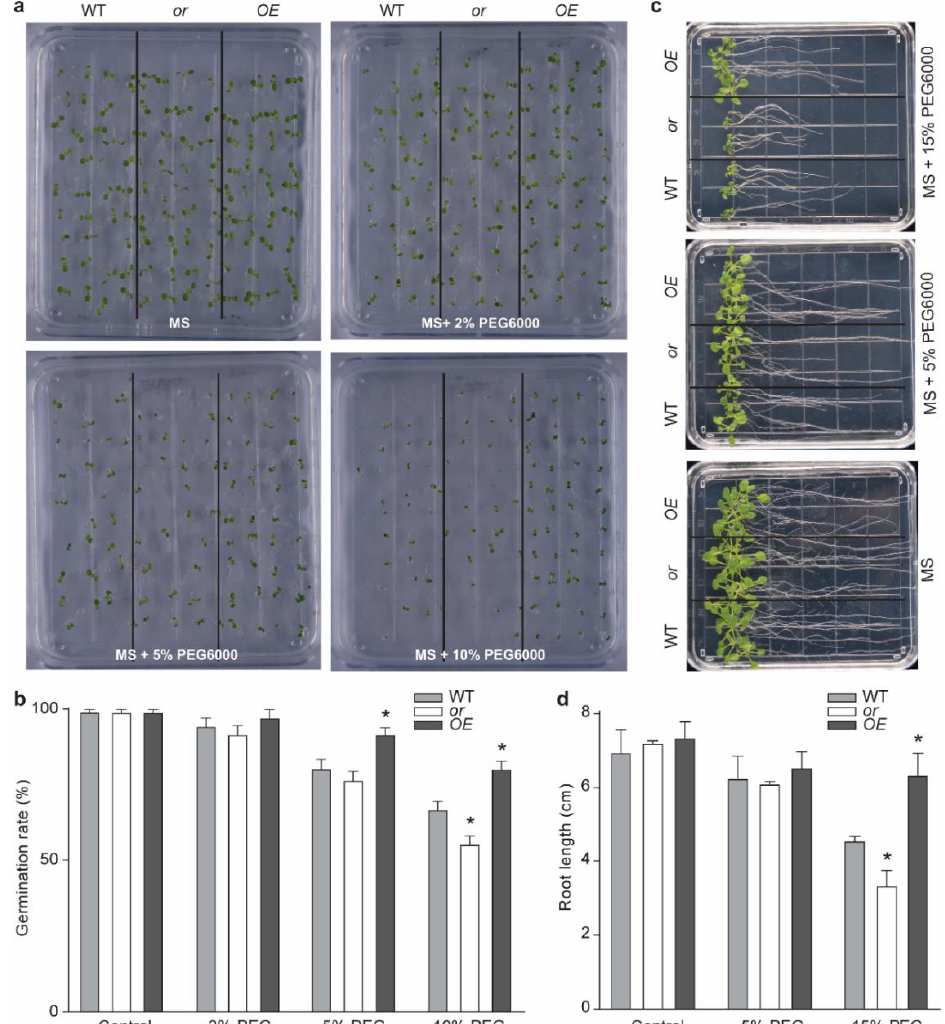
Figure 2. Response of different OR transgenic lines to PEG6000 treatment. ( a ) Germination of the wild-type (WT) and OR -overexpressing ( OE ) and -silencing ( or ) seeds on Murashige-Skoog (MS) plates, supplemented with indicated concentrations of PEG6000. ( b ) The germination rate of ( a ). Data are means ± SEM ( n = 120. * p < 0.05, Student’s t test). ( c ) Growth of normally germinated seedlings on MS plates, supplemented with indicated concentrations of PEG6000. ( d ) Root length of different lines in ( c ). Data are means ± SEM (three plates with 15 seedlings were counted. * p < 0.05, Student’s t test).